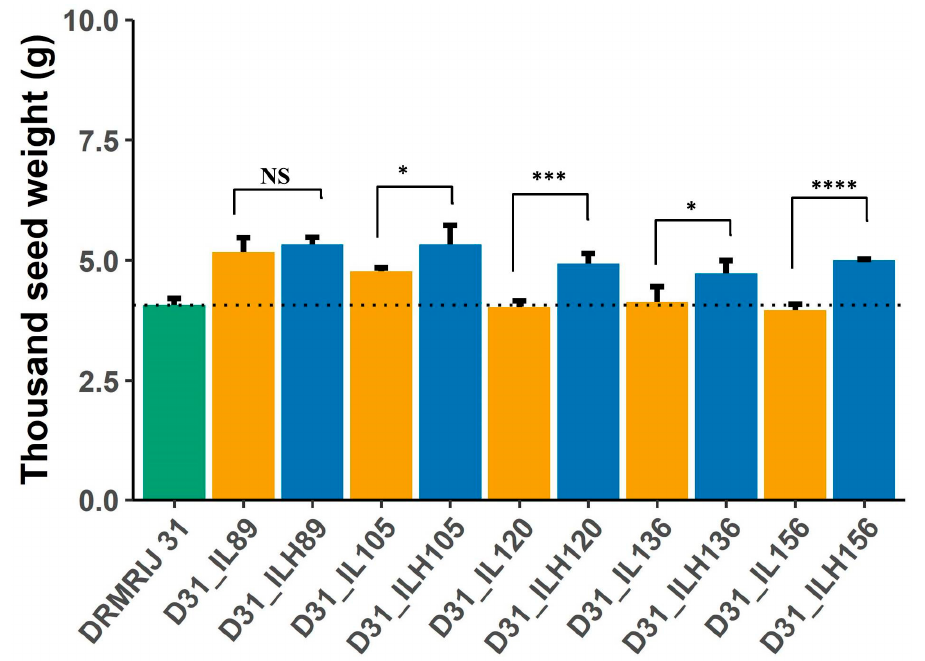
Figure 5. Mean performance of DRMRIJ 31, introgression lines in its genetic background (D31_ILs) and introgression line hybrids (D31_ILHs) for thousand seed weight (* significant at p = 0.1; *** significant at p = 0.01; **** significant at p = 0.001; NS = Non Significant).